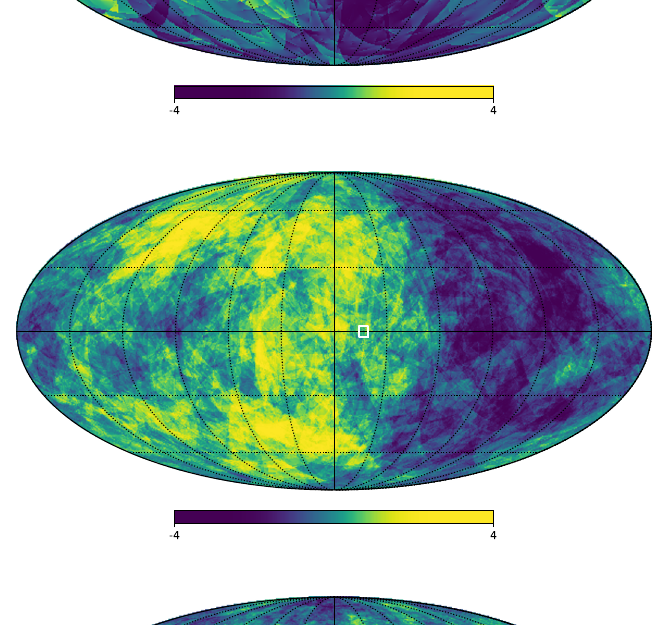
p (cid:24) A (cid:11) em ) and is measured in